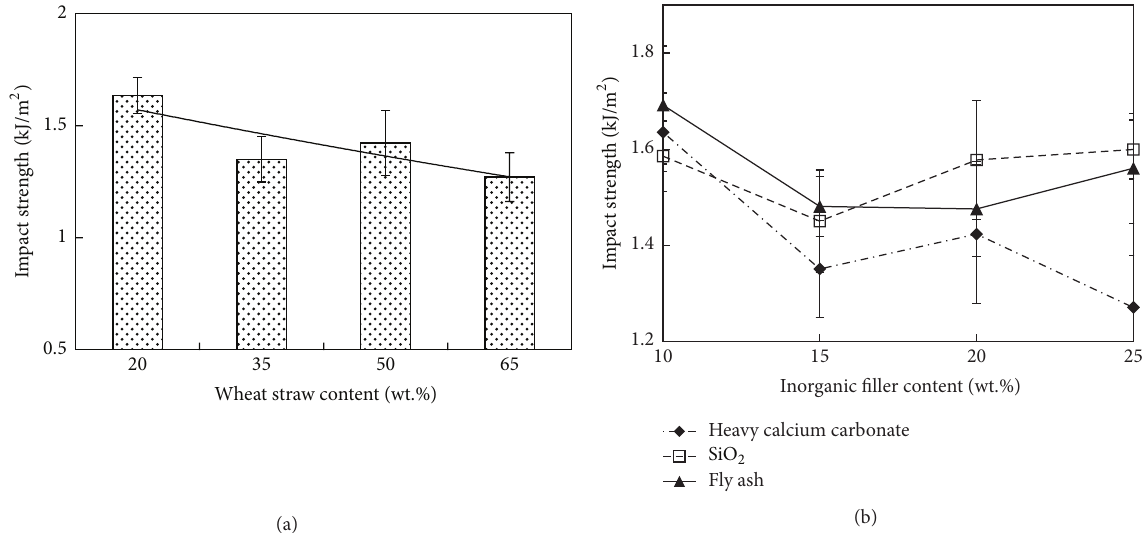
Figure 3: Impact strength of (a) WS filled PP composites and (b) WS and inorganic filler reinforced PP